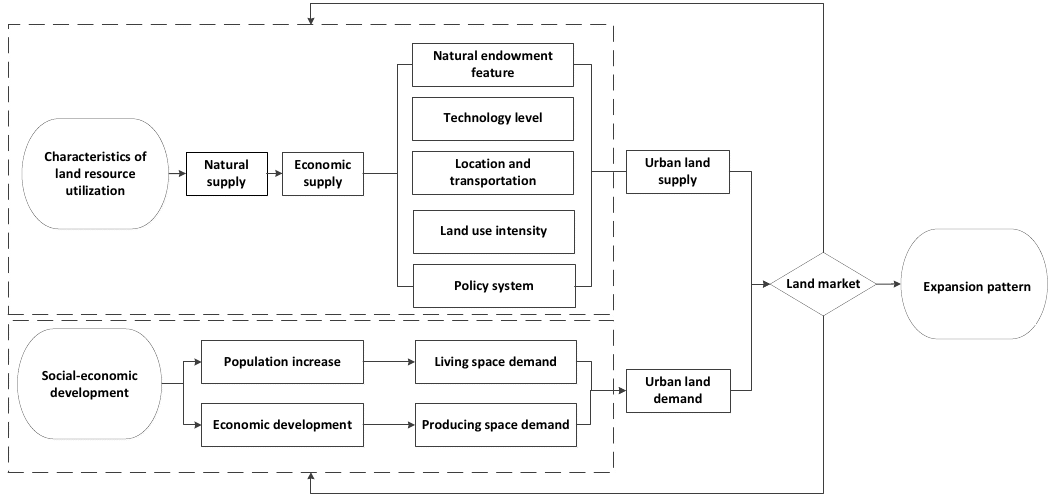
Figure 2. The theoretical framework of supply/demand-induced urban land expansion.